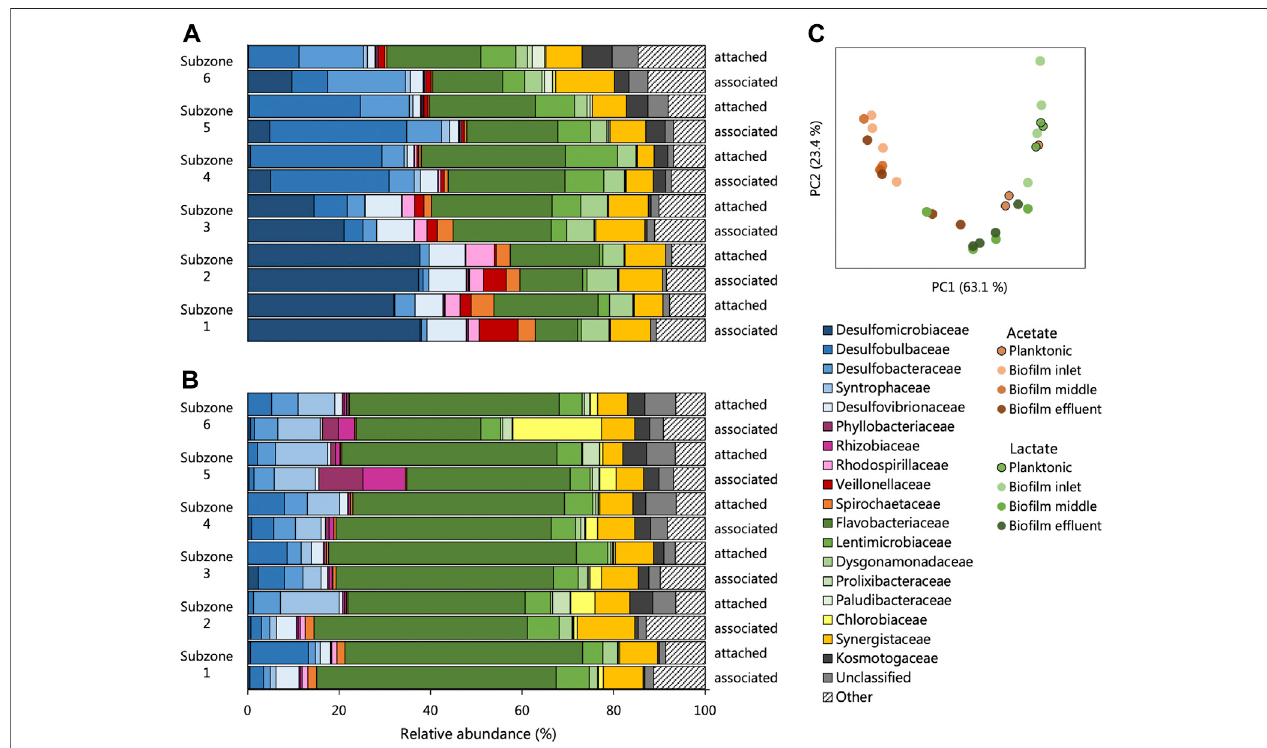
FIGURE 8| The composition of the attached and associated communities, at the taxonomic family level, of the (A) acetate and (B) lactate supplemented UAPBRs at a one-day HRT. (C) Principal component analysis based on weighted Unifrac distances assesses the beta-diversity between these communities as well as the planktonic communities at a one-day